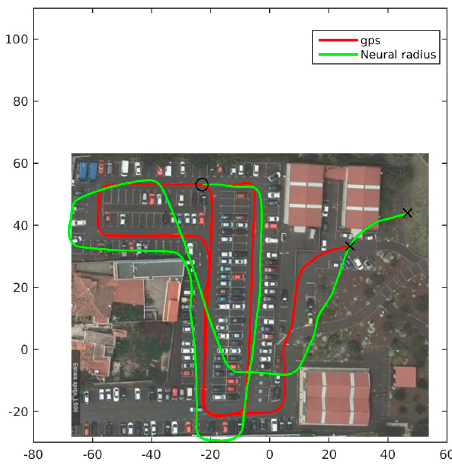
Figure 11. Neural odometric model test, including history information and wheel radius. Solid red ground truth GPS route. Solid green neural calculation route.